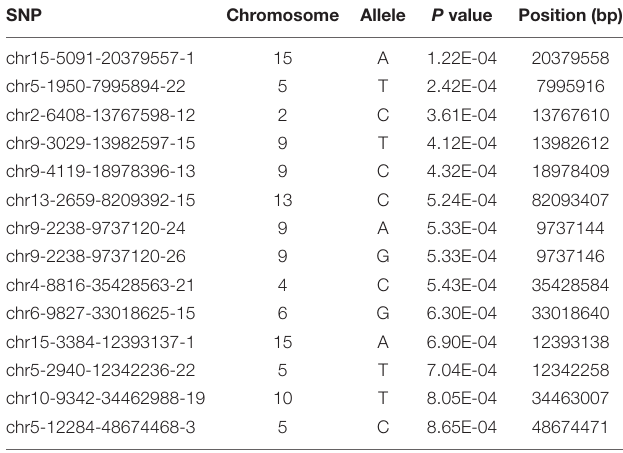
TABLE 2 | Information of the top fourteen SNPs associated with